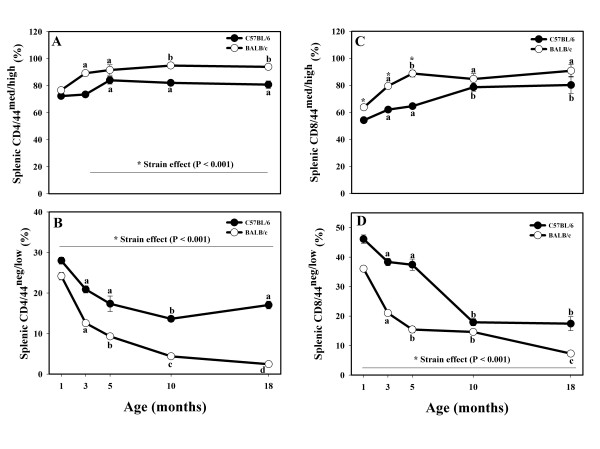
Effects of age and strain on CD4+/CD44med/high (A), CD4+/CD44neg/low (B), CD8+/CD44med/high (C), and CD8+/CD44neg/low (D) splenocytes isolated from the spleens of male C57BL/6 and BALB/c mice up to 18 months of age. * Indicates strain differences within a particular age category (P < 0.001). a,b,c,d Indicates age differences within a particular strain (P < 0.05).